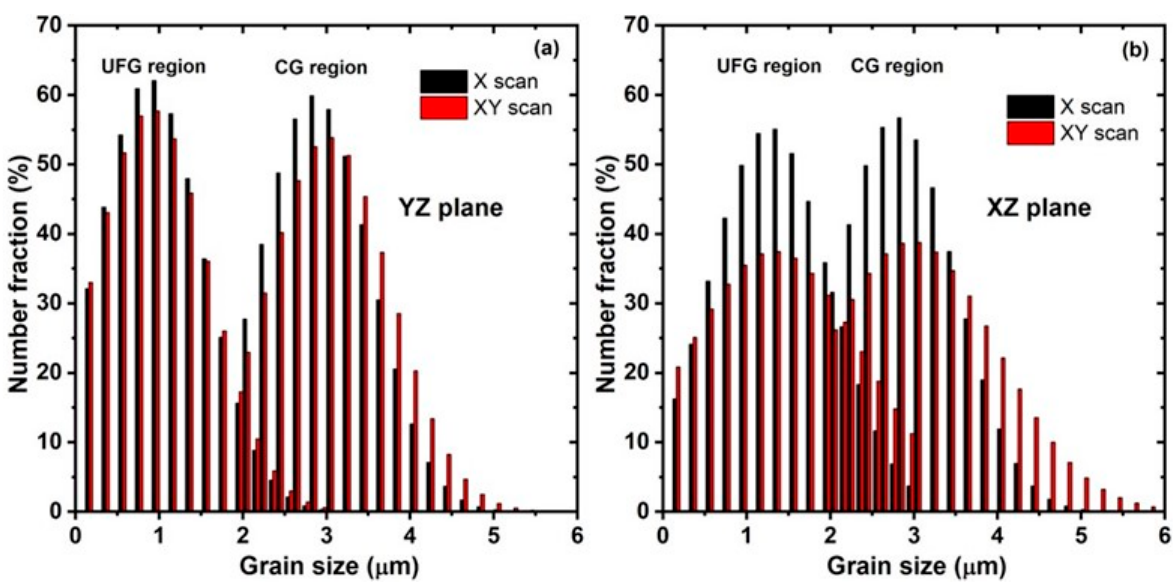
Figure 9. Grain size distributions of ( a ) the YZ and ( b ) the XZ plane for the X- and XY-scan samples with UFG and CG regions.